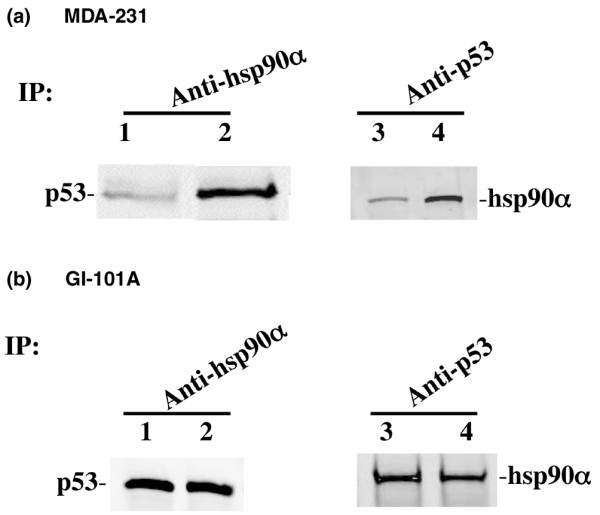
Protein-protein interaction analysis of p53 and the α isoform of heat shock protein 90 (Hsp90α). (a) MDA-231 cell lysates from untreated cells (lanes 1 and 3) and cells treated for 4 hours with 100 μM PRIMA-1 (lanes 2 and 4) were immunoprecipitated (IP) with anti-Hsp90α monoclonal antibody and subjected to Western blotting (WB) with anti-p53 (DO-1) monoclonal antibody (lanes 1 and 2) in addition to reciprocal immunoprecipitation with DO-1 and Western blotting with anti-Hsp90α (lanes 3 and 4). (b) GI-101A cell lysates from untreated cells (lanes 1 and 3) and cells treated for 4 hours with 100 μM PRIMA-1 (lanes 2 and 4) were immunoprecipitated with anti-Hsp90α monoclonal antibody and subjected to Western blotting with anti-p53 (DO-1) monoclonal antibody (lanes 1 and 2) in addition to reciprocal immunoprecipitation with DO-1 and Western blotting with anti-Hsp90α (lanes 3 and 4).